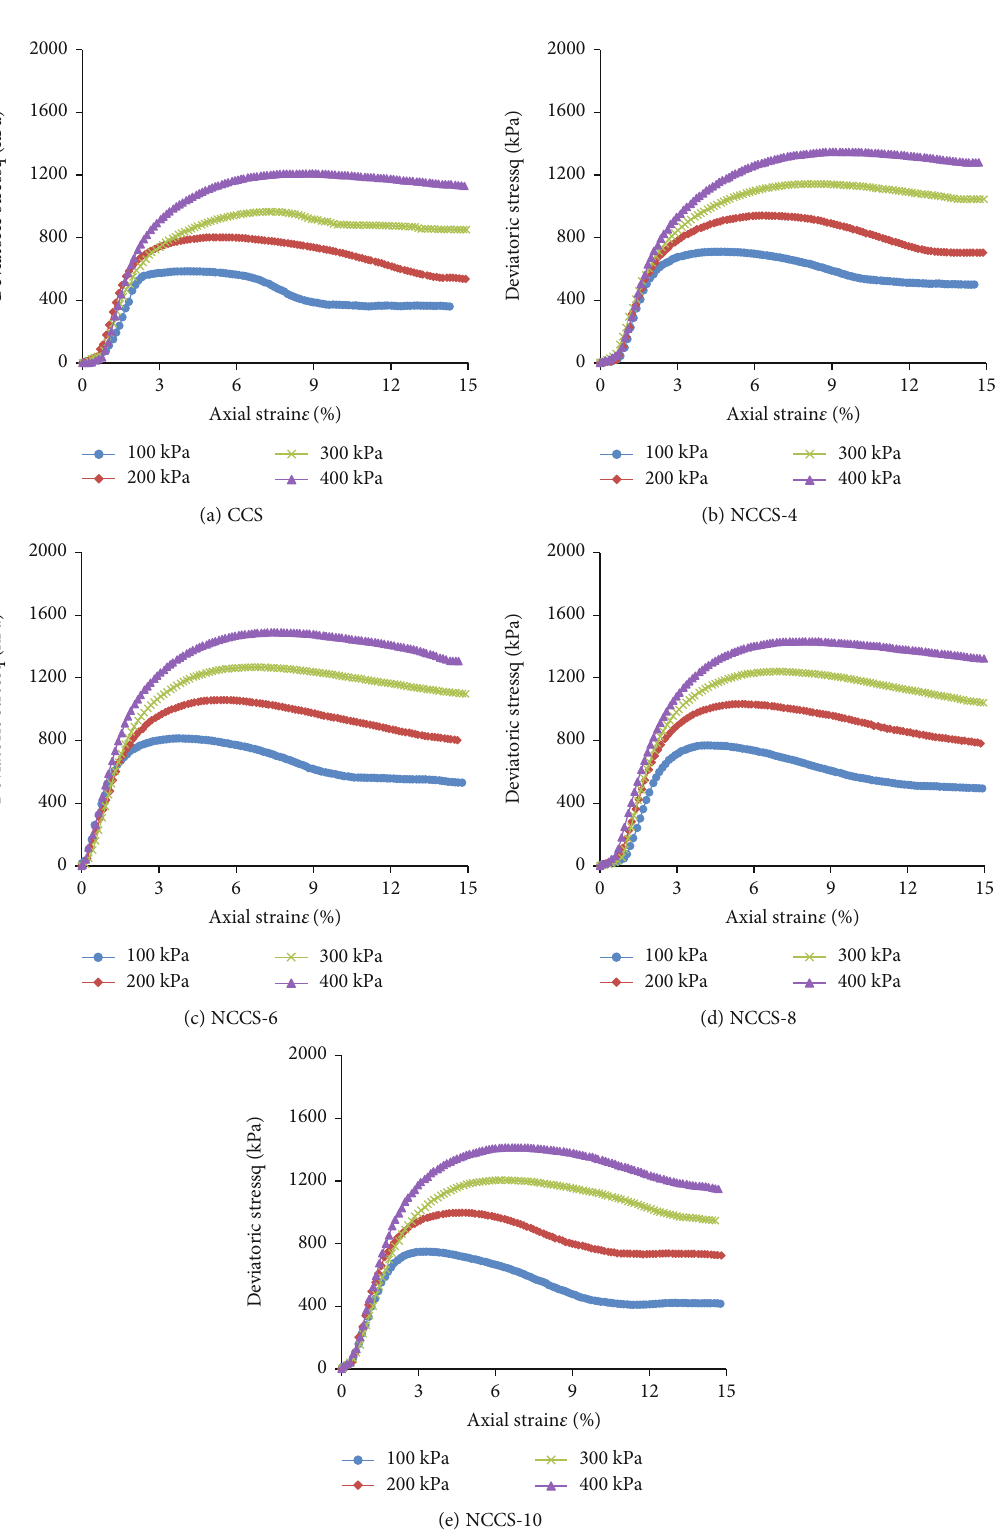
Figure 1: Stress-strain curves of CCS and